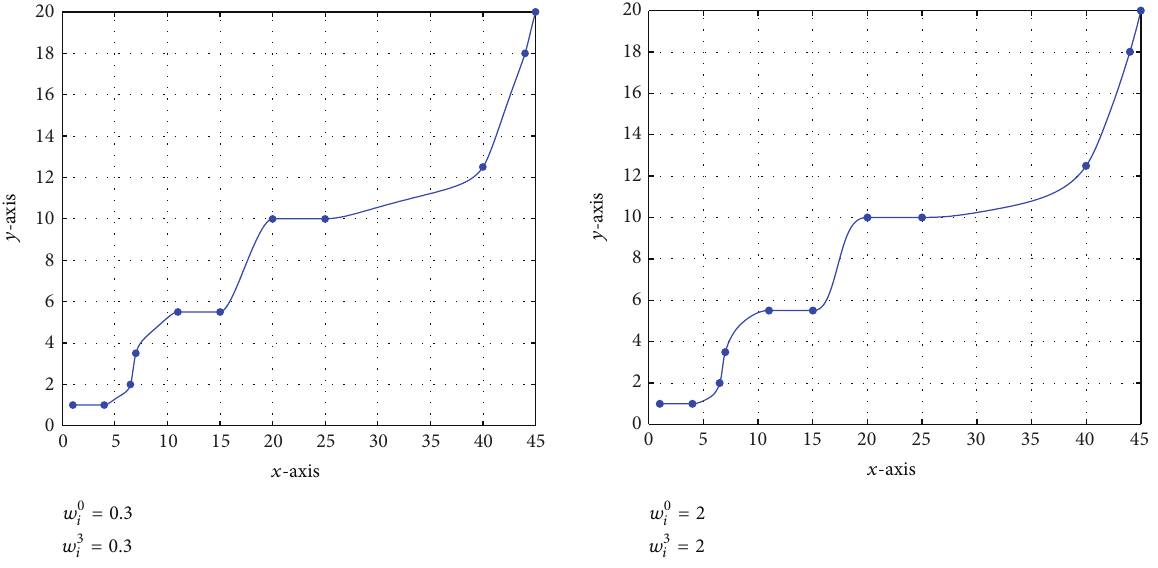
Figure 6: Monotonicity preserving curve with different values of shape parameters.